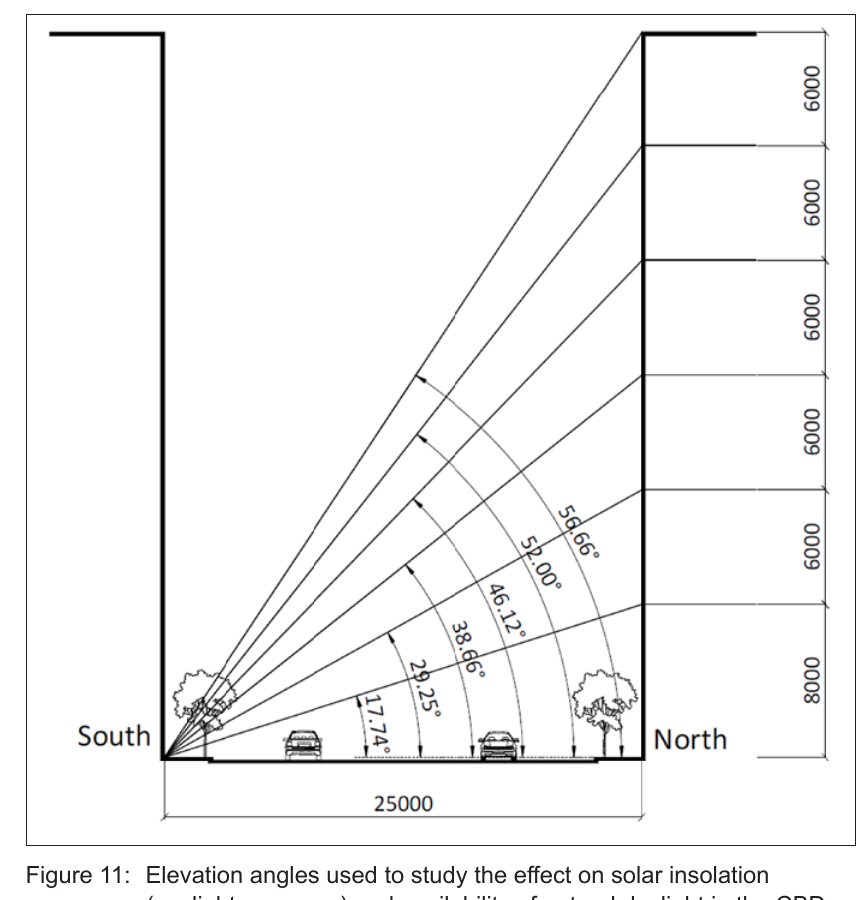
Figure 11: Elevation angles used to study the effect on solar insolation (sunlight exposure) and availability of natural daylight in the CBD of Pretoria with different overshadowing building heights. A total street width of 25 m was used. The overshadowing building is on the northern side and the overshadowed building on the southern side. The actual orientation of the CBD of Pretoria was used in the calculation of solar insolation and natural daylight.